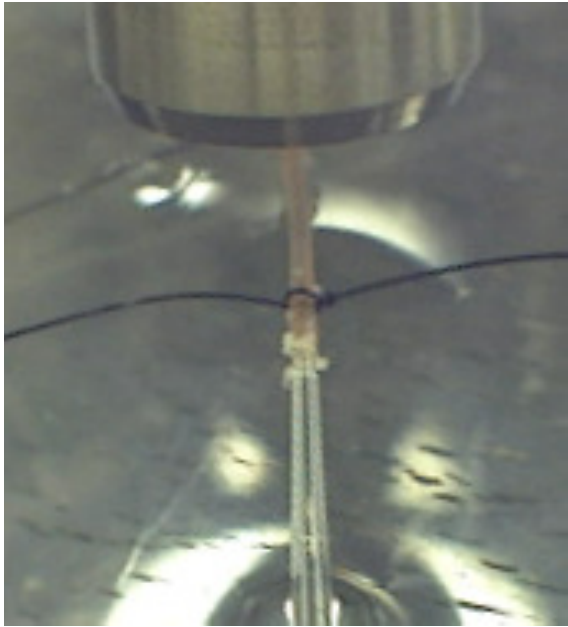
Figure 21. Photography of the aorta cannulation.